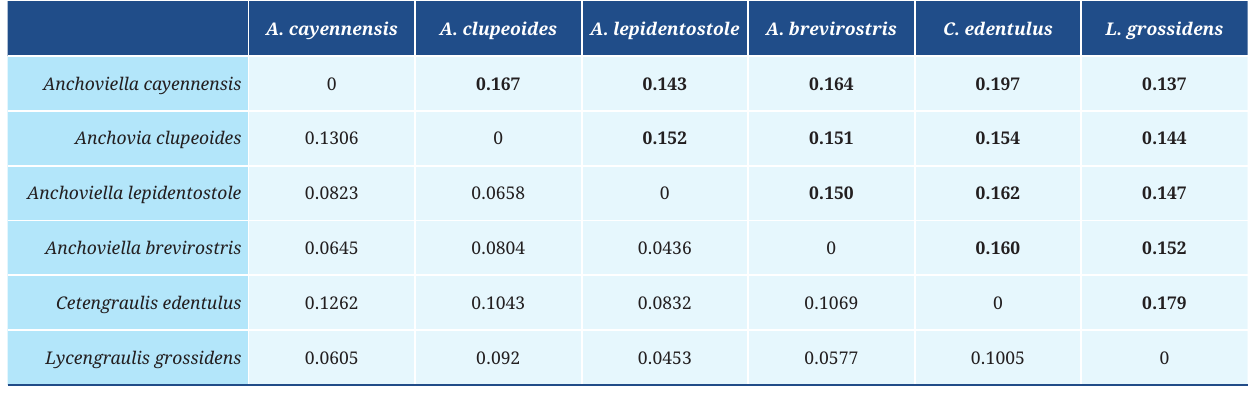
TABLE 1 | Procrustes distance (diagonal bottom, black) and estimates of pairwise genetic divergence with the K2P evolutionary model (diagonal top, bold), among representatives of Engraulidae from the São Francisco River estuary, northeastern Brazil.